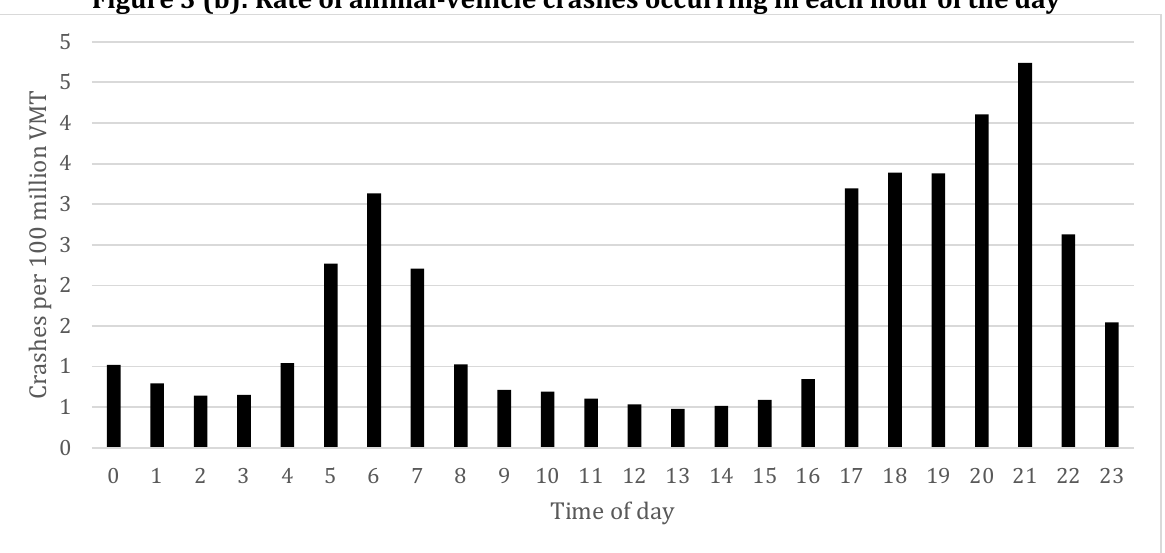
Figure 3 (b): Rate of animal-vehicle crashes occurring in each hour of the